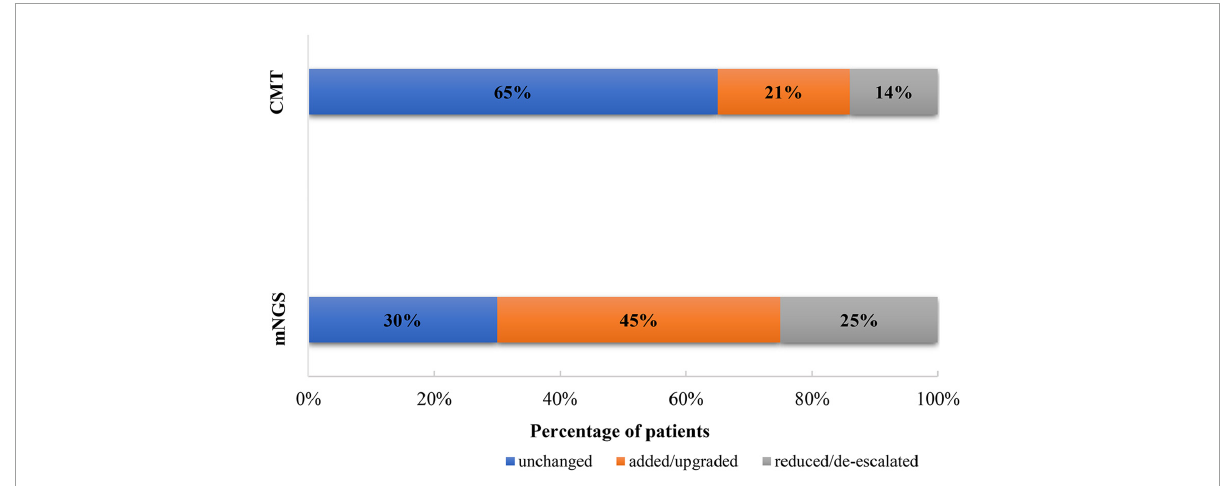
FIGURE4 Adjustment of antibiotics based on metagenomic next-generation sequencing (mNGS) and conventional microbiological test (CMT) results.